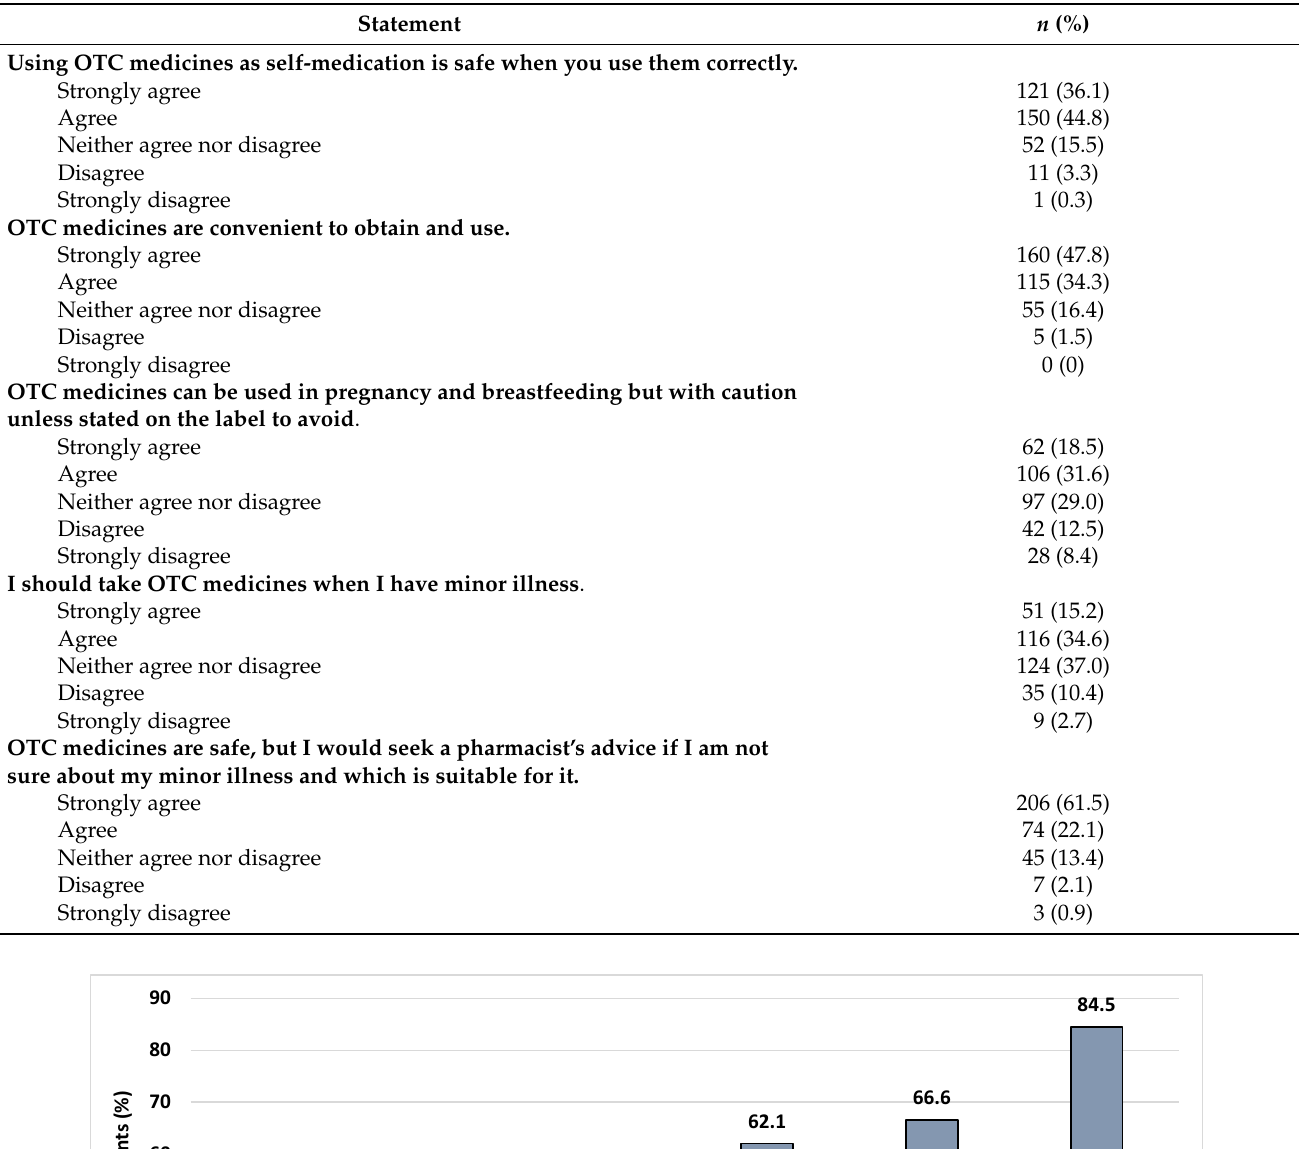
Table 4. Attitudes of respondents to the use of OTC medicines.